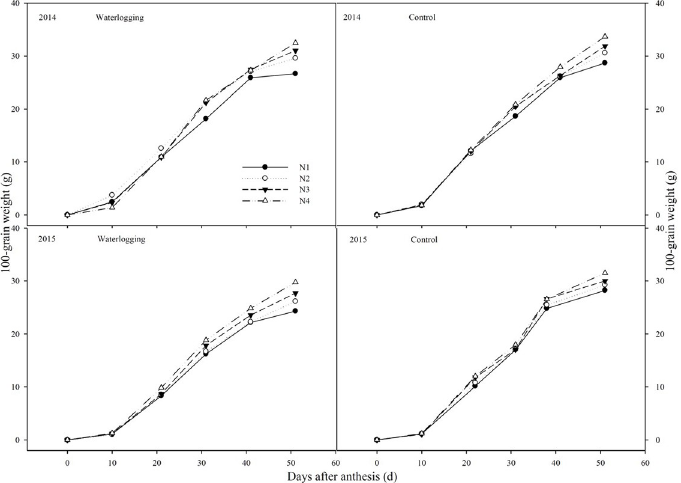
Fig 8. Grain-filling in different N treatments during post-anthesis stage. N1: 100% N applied as basal fertilizer, N2: 70% N applied as basal fertilizer and 30% N applied at the jointing stage, N3: 50% N applied as basal fertilizer and 50% N applied at the jointing stage, N4: 30% N applied as basal fertilizer, 50% N applied at the jointing stage and 20% N applied at the big flare